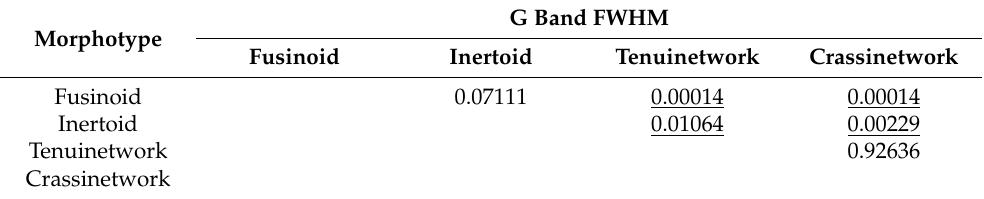
Table 10. Results of the Tukey’s HSD multiple comparison test for the I D1 /I G ratio. I D1 /I G Ratio Morphotype Fusinoid Inertoid Tenuinetwork Crassinetwork Fusinoid 0.49077 0.02942 0.07602 Inertoid 0.00021 0.00073 Tenuinetwork 0.97940 Crassinetwork